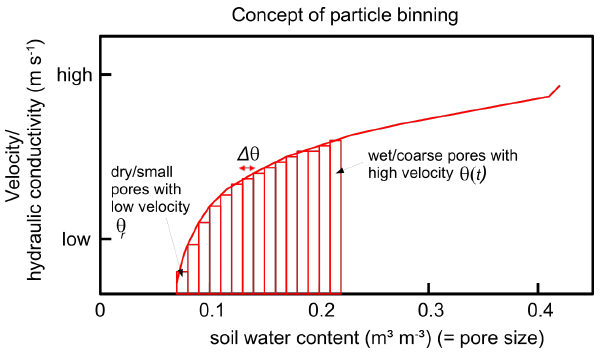
Figure 1. Particle binning concept. All particles within an element of the Euler grid are distributed to bins (i.e. red rectangles) repre- senting fractions of the actual soil water content stored in different pore sizes. Displacements of these particle fractions are determined by the corresponding flow velocities and diffusivities (figure taken from Sternagel et al.,